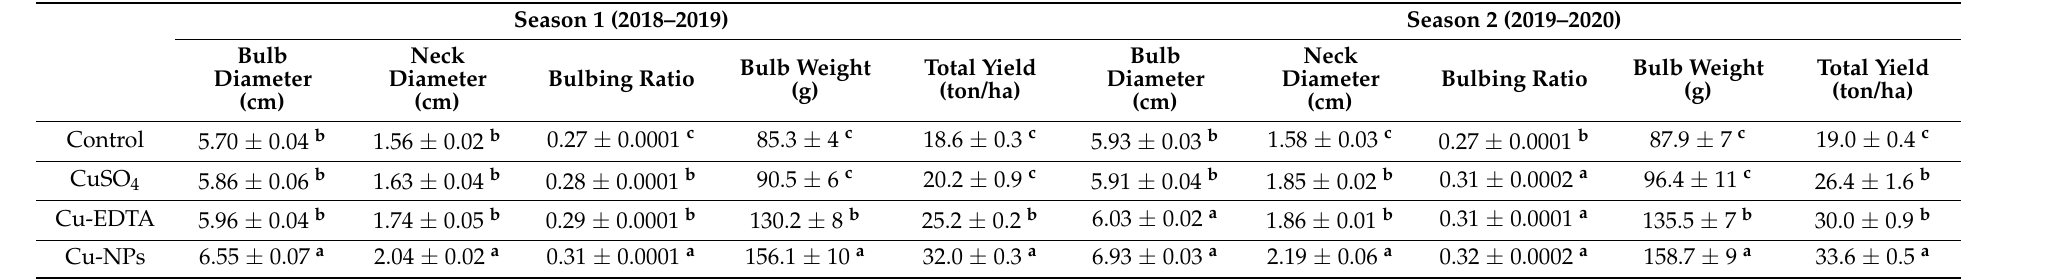
Table 5. Effects of different sources of Cu on the yield and bulb quality of onion in two seasons (2018/2019 and 2019/2020).